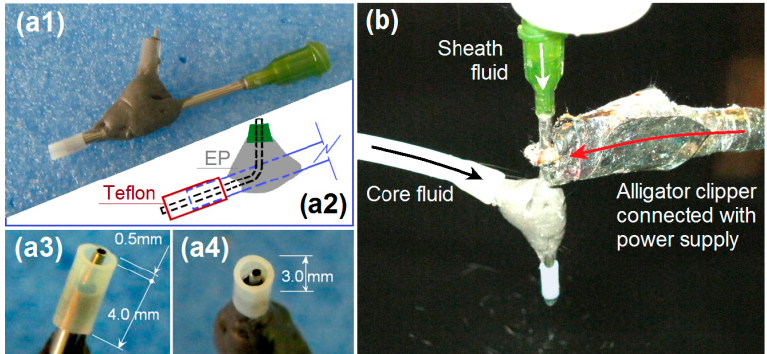
Figure 2. Implementation of the modified coaxial electrospinning: ( a1 ), ( a3 ), and ( a4 ) the home-made concentration spinneret, ( a2 ) a diagram showing the internal paths of sheath and core working fluids; ( b ) a digital picture of the working process.